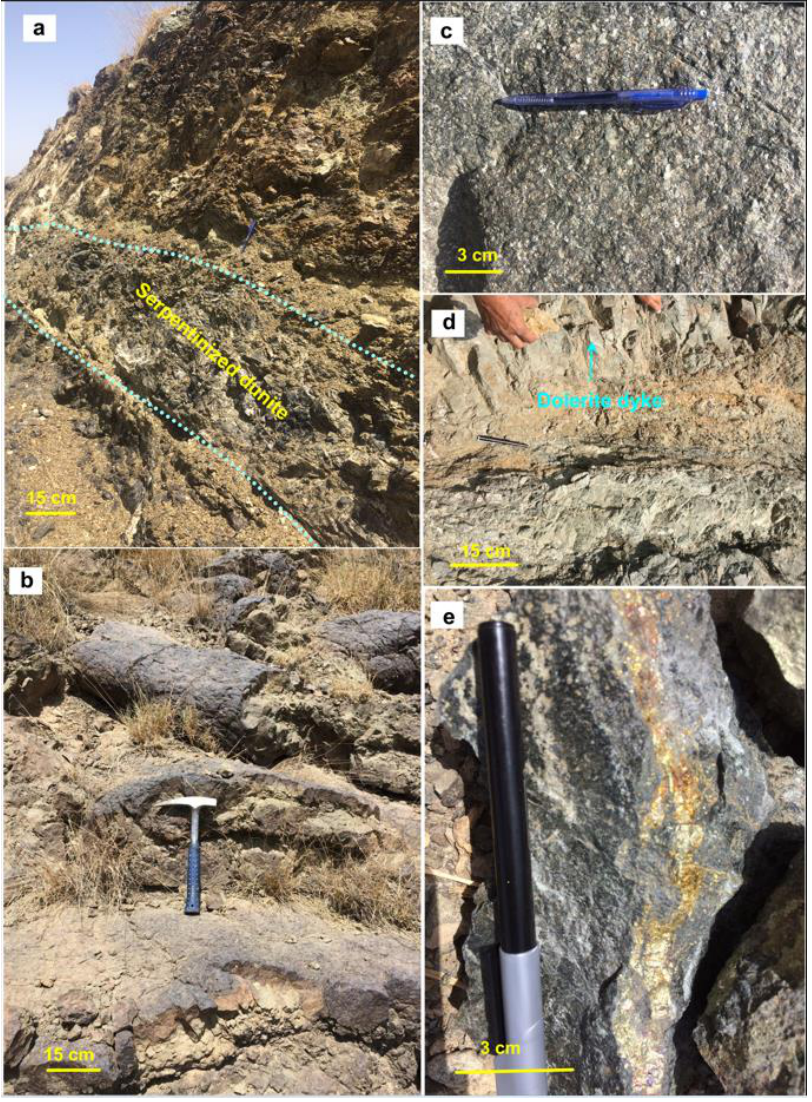
Figure 3. Field photographs showing different lithologies of the WOC. ( a ) Peridotite outcrop having a well exposed layer of serpentinized dunite; ( b ) Pillow lavas; ( c ) Close-up view of dunite outcrop; ( d ) Dolerite dyke; ( e ) Altered basalt having chalcopyrite mineralization as fracture filling.